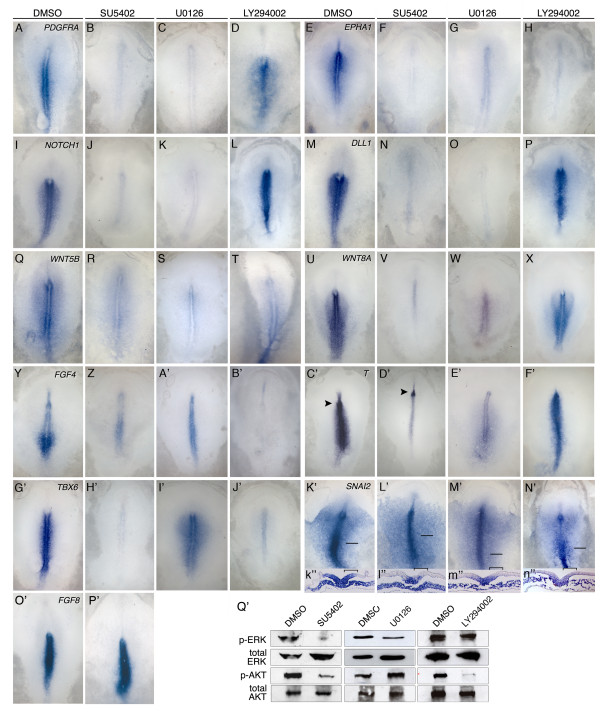
Effects of SU5402, the MEK inhibitor U0126, and the PI3K inhibitor LY294002 on gene expression in the primitive streak region. A-P': Whole mount images showing mRNA expression in control (DMSO), SU5402, U0126 and LY294002 treated embryos. Arrows in C'-D' point to Hensen's node. Brackets in k"-l" indicate the preingression epiblast. Q': Western blot analysis comparing total versus phosphorylated ERK1/2 (p-ERK) and AKT (p-AKT) in the preingression epiblast and primitive streak of DMSO versus SU5402, U0126 and LY294002 treated embryos.